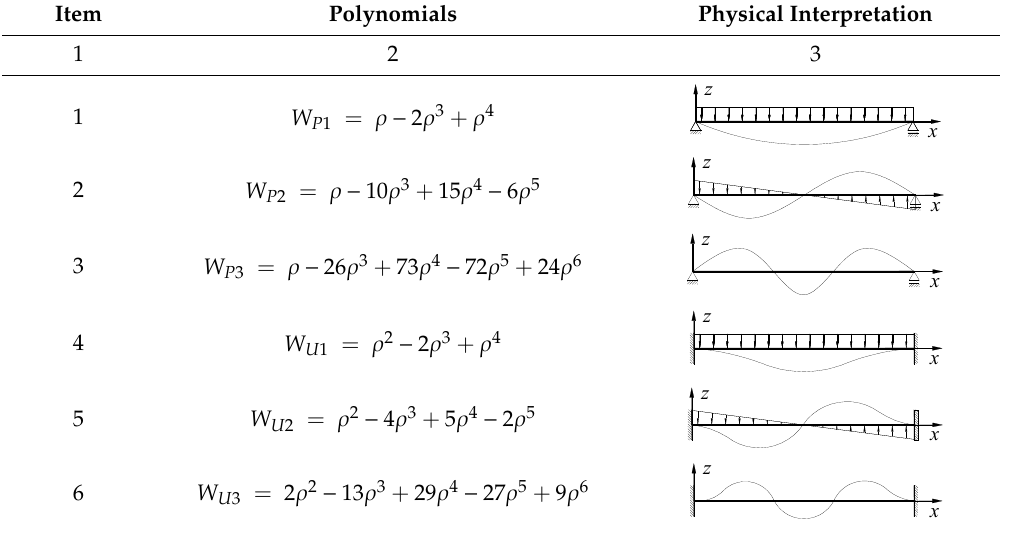
Table 1. Polynomials used and their physical interpretation (where ρ = x / L ) [34,43]. Item Polynomials Physical Interpretation